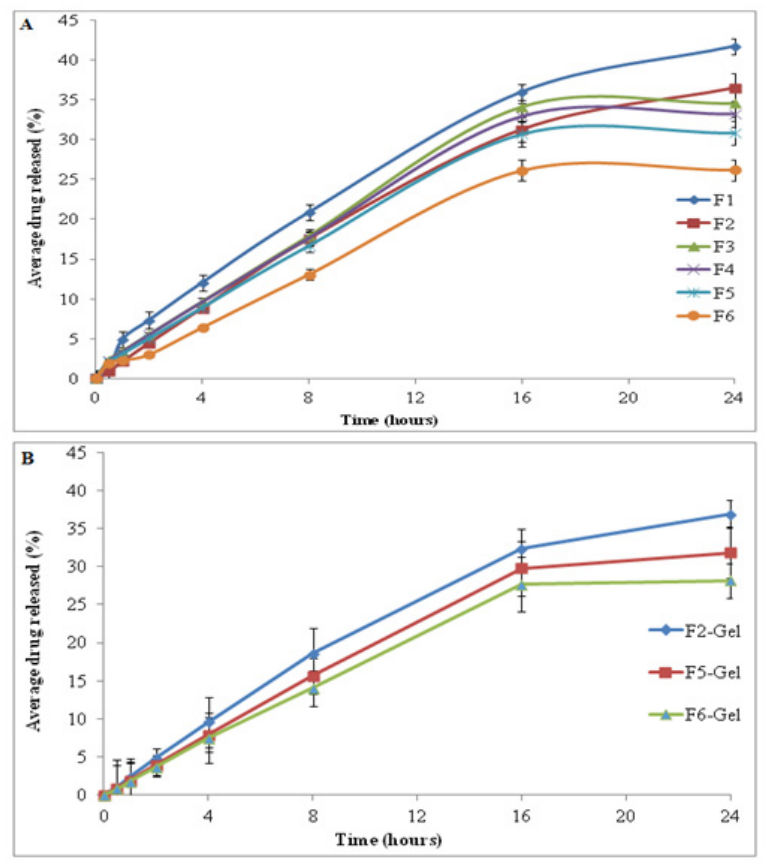
Figure 3. Drug release pattern from ( A ) SLN formulations and ( B ) SLN-loaded gel .